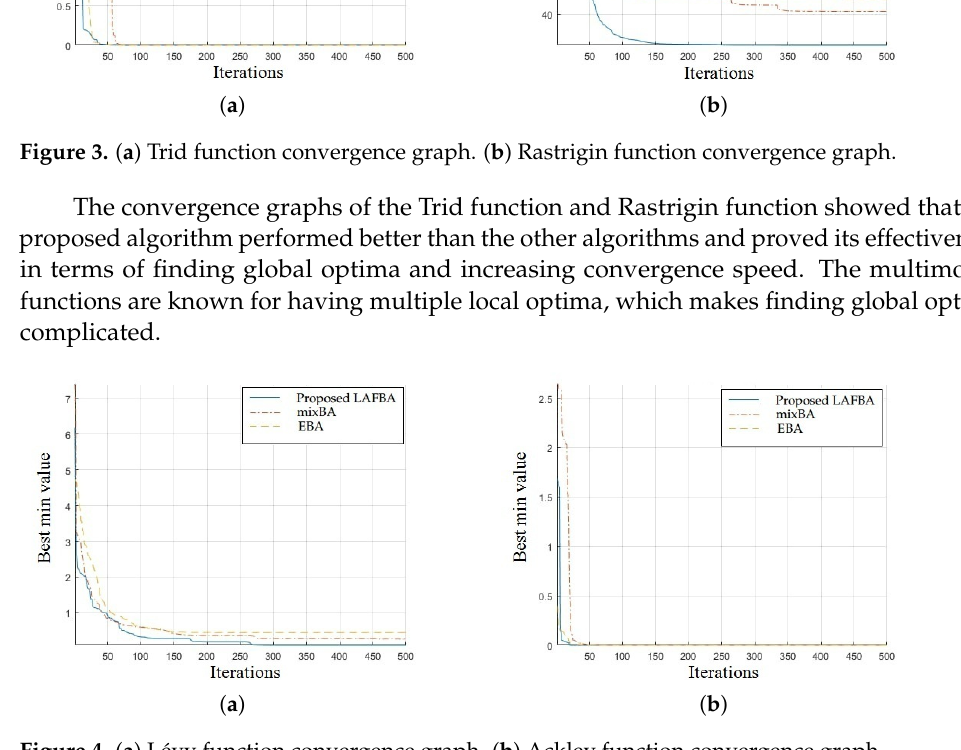
Figure 4. ( a ) Lévy function convergence graph. ( b ) Ackley function convergence graph.